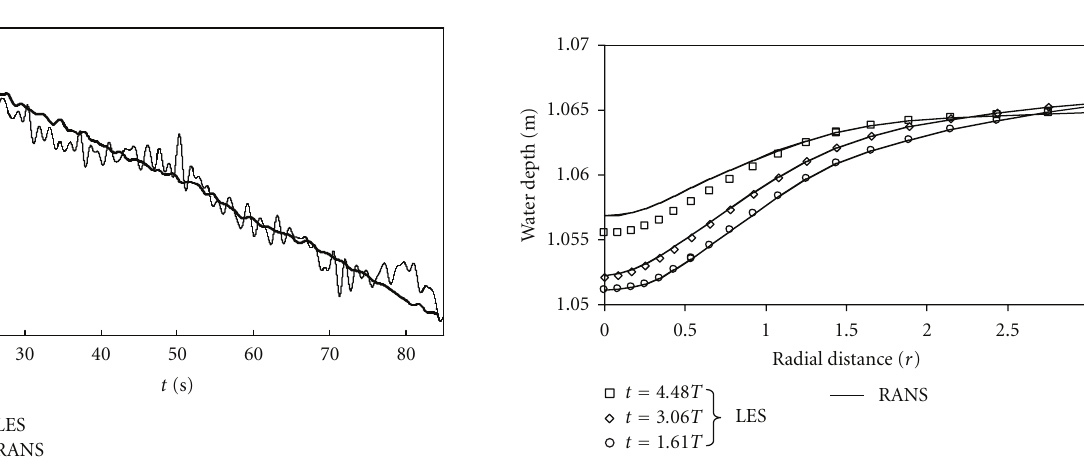
Figure 11: Radial distribution of tangential velocity calculated by RANS and